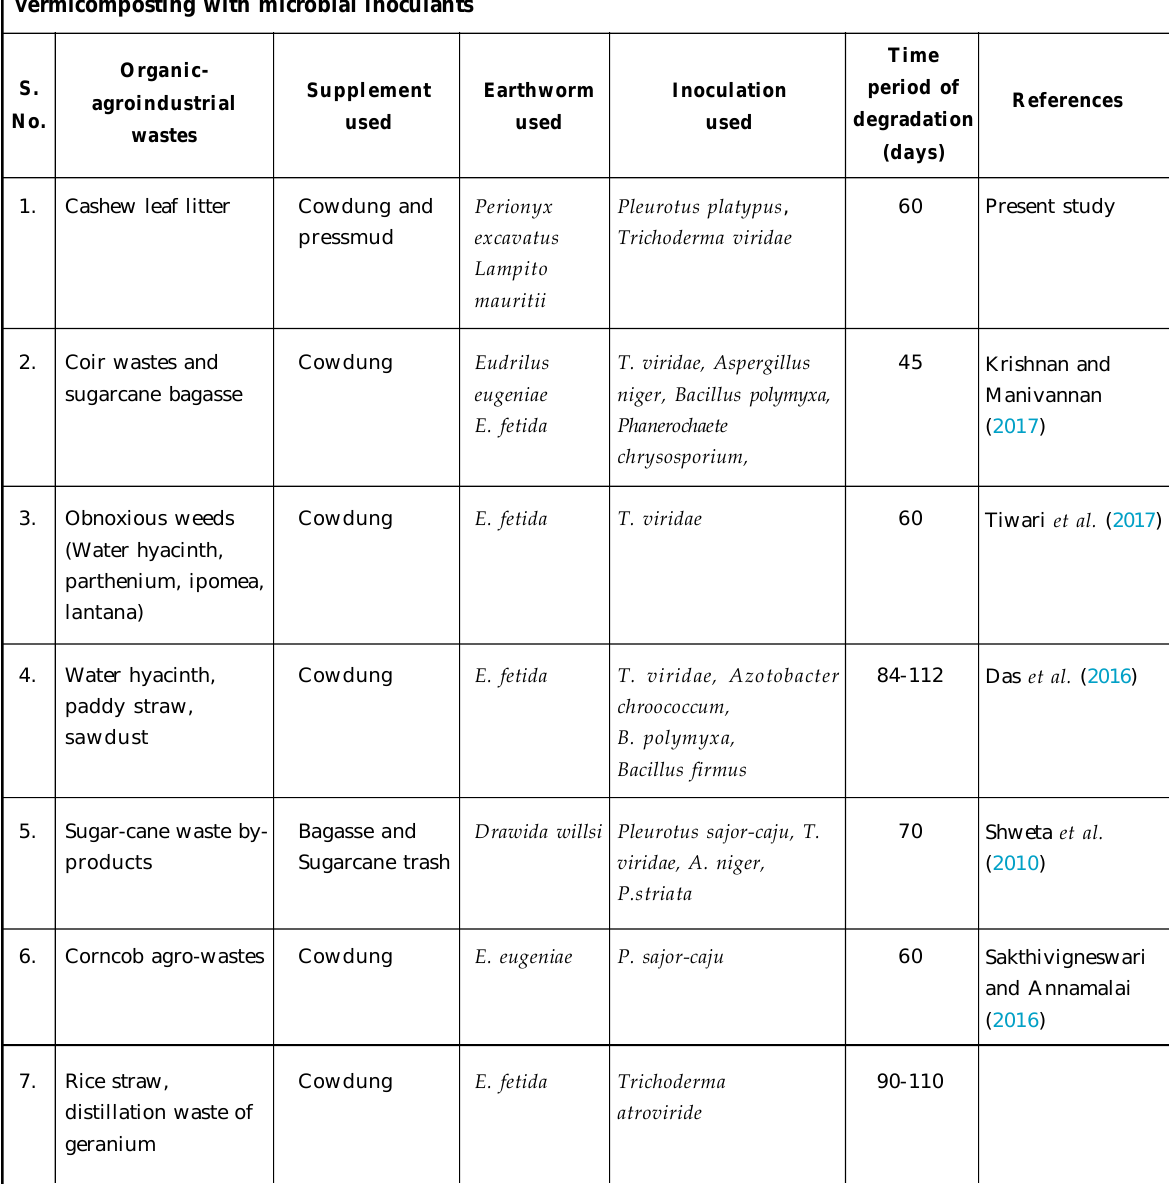
Cashew leaf litter